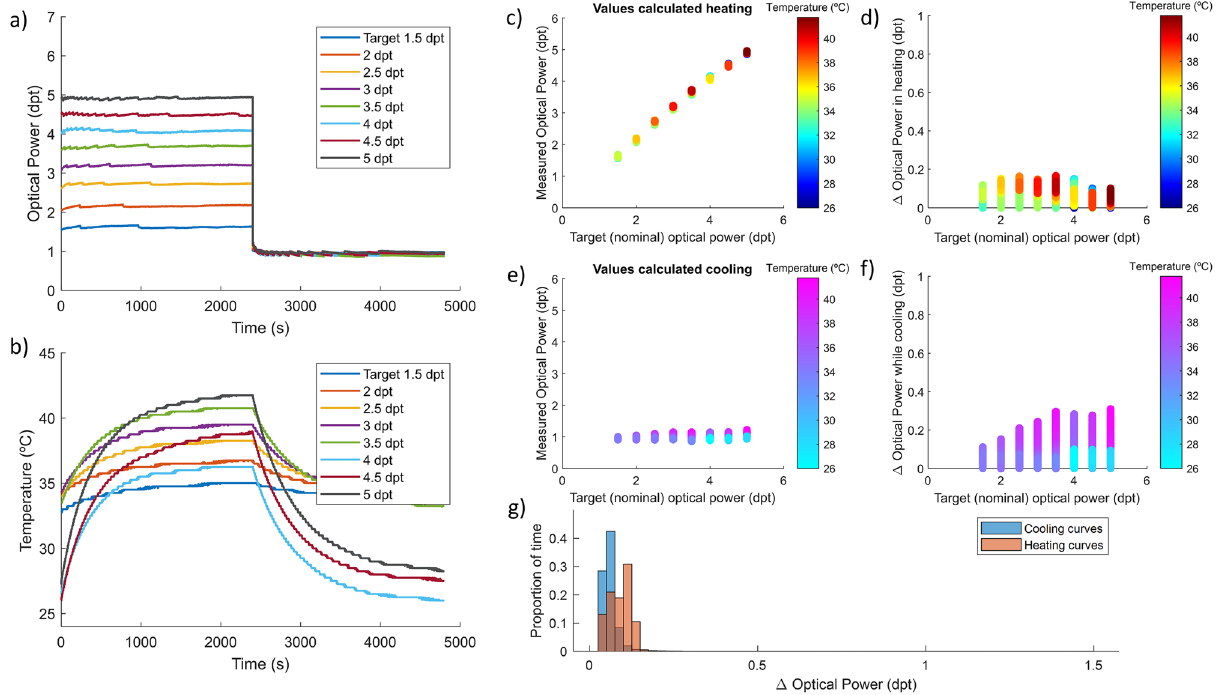
Figure 4. Experimental model compensation of temperature effect in a TL during long static states of different optical power. ( a ) Graphical description of the result of compensation strategy showing the optical power stabilization in time. ( b ) Internal temperature profile of the lens during the experiment with different target power states. Measured optical power of the lens while heating ( c ) with different driving signals and cooling ( e ) at rest state. Estimated deviation calculated from the difference between target power and measured optical power in the heating ( d ) and cooling ( f ) processes. ( g ) Histogram of optical power deviation while heating (red) and cooling (blue).